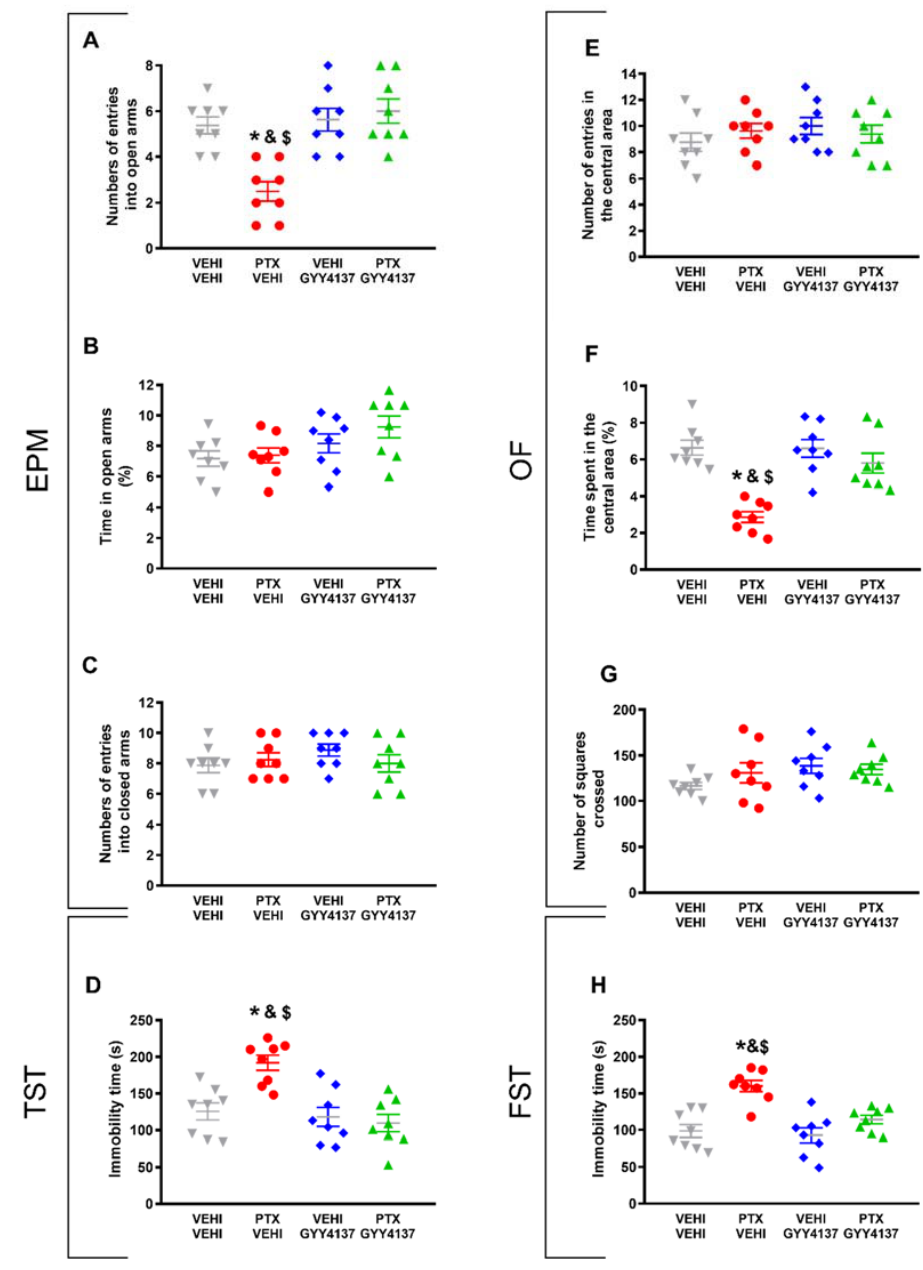
Figure 5. Effects of GYY4137 treatment on the emotional disorders accompanying PTX-induced neuropathic pain. Effects of the repetitive administration of 35 mg/kg of GYY4137 or vehicle from days 18 to 21 after PTX or vehicle (VEHI) injection on the anxiety- (EPM and OF tests) and depressive- like behaviors (TST and FST) associated with CIPN. In the EPM test, the number of times that animals entered into the open arms ( A ), the percentage of total time spent in open arms ( B ), and the number of entrances into the closed arms ( C ) are represented. In the OF test, graphs show the number of entries into the central area ( E ), the percentage of time spent within the central area ( F ), and the total number of squares crossed ( G ). Figures ( D , H ) display the time spent in immobility (s) in the TST ( D ) and the FST ( H ). In all panels, * indicates significant differences vs. the vehicle–vehicle-treated mice; &, vs. the vehicle–GYY4137 ‐ treated animals; and $, vs. the PTX–GYY4137 ‐ treated animals ( p < 0.05, one ‐ way ANOVA followed by the SNK post hoc test). Data are expressed as mean values ± SEM; n = 8 animals per experimental group.